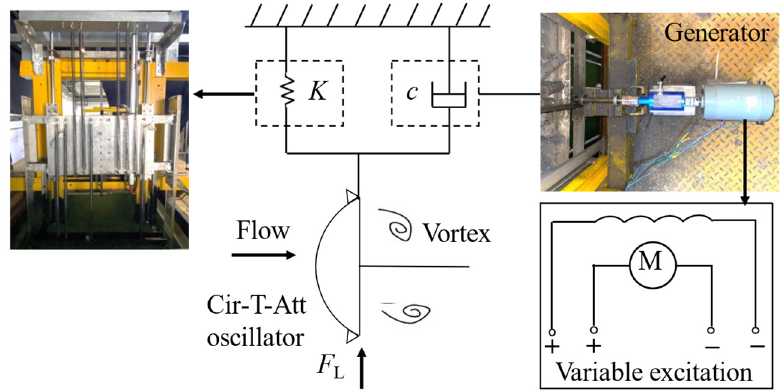
Figure 2. Layout of experiment.